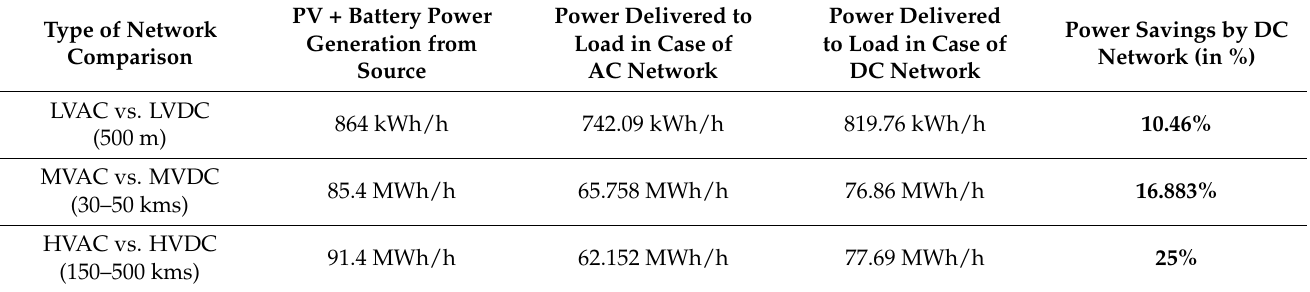
Table 5. Total system power savings by a DC network as compared to an AC